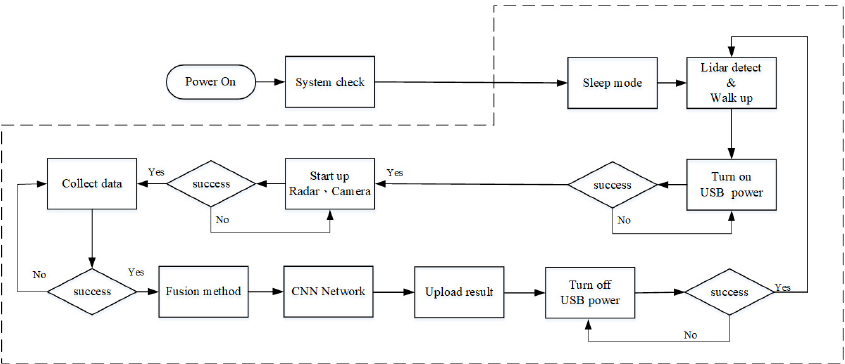
Figure 9. Parking meter system flow